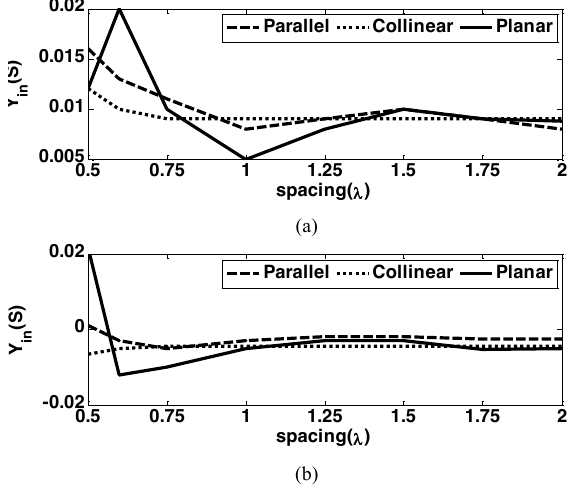
FIGURE 7. Input admittance (S) of different arrangements of infinite array of straight wire antennas versus normalized spacing based on MoM, (a): real and (b): imaginary parts.